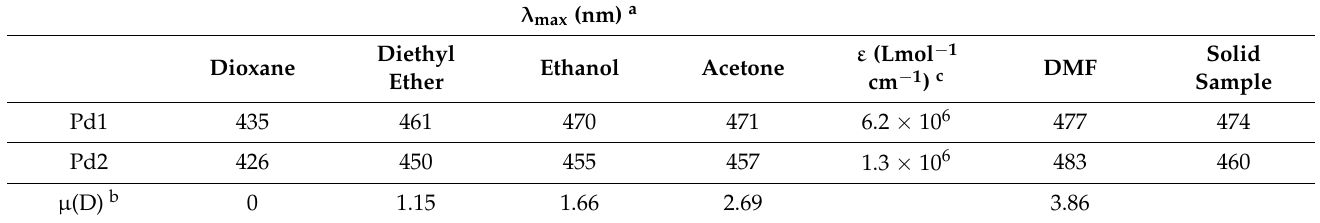
Table 1. UV-VIS absorption maxima for Pd1 and Pd2 in solvents at different polarities and as solid